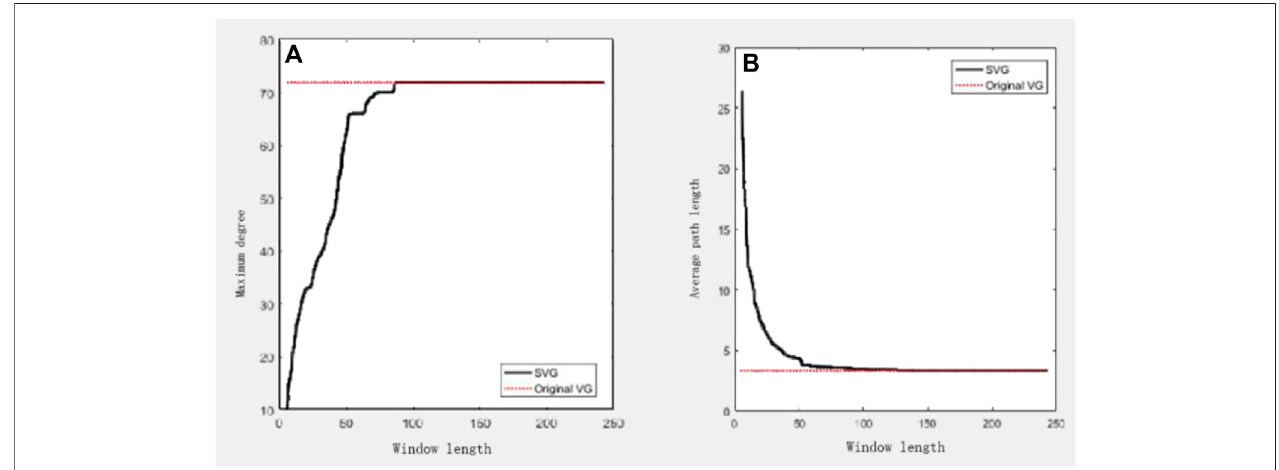
FIGURE6| IllustrationoftherelationshipsbetweendifferentparametersandwindowlengthforthestockopeningpricedataofShenzhenCauTechnologyCo.,Ltd. in 2018 (A) maximum degree; (B) maximum average length.